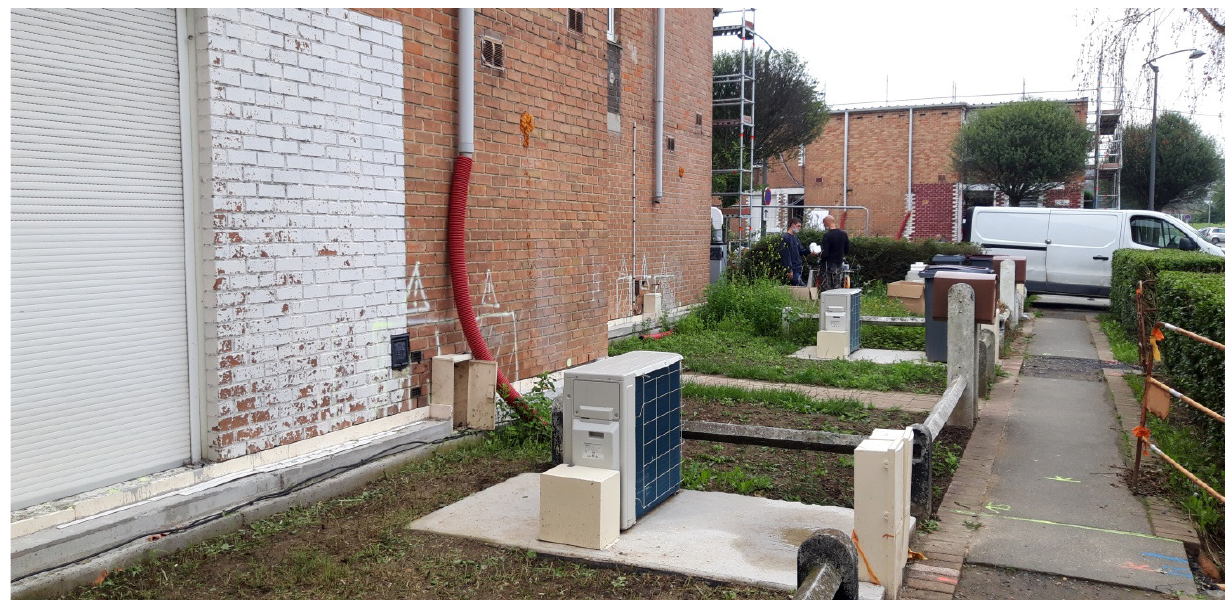
Figure 6. Heat pumps and meters in